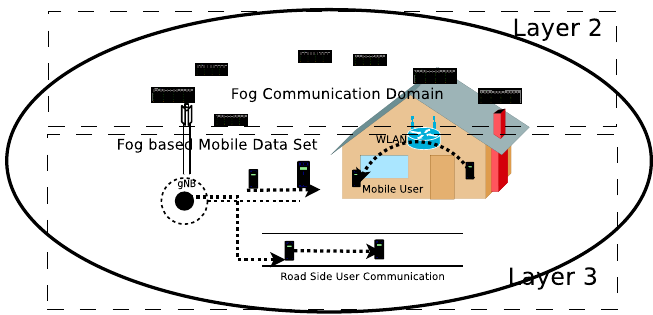
Figure 2. Device-driven 5G fog networks schema. It supports minimum infrastructure dependent communication between the mobile nodes and supported by fog